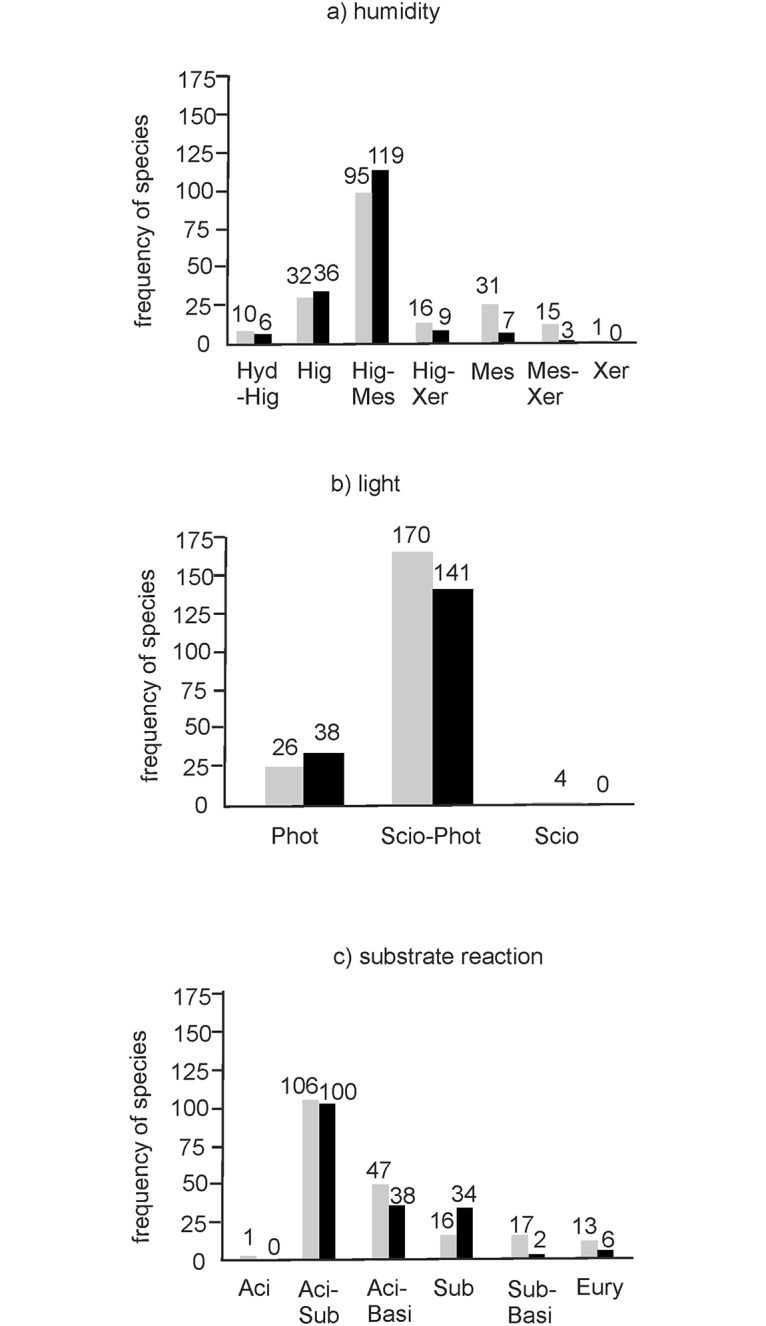
Ecological requirements of the bryophyte species found in the donor (gray bars) and restoration (black bars) meadows.(a) Humidity. (b) Light. (c) Substrate reaction. Explanations: see Fig 2.